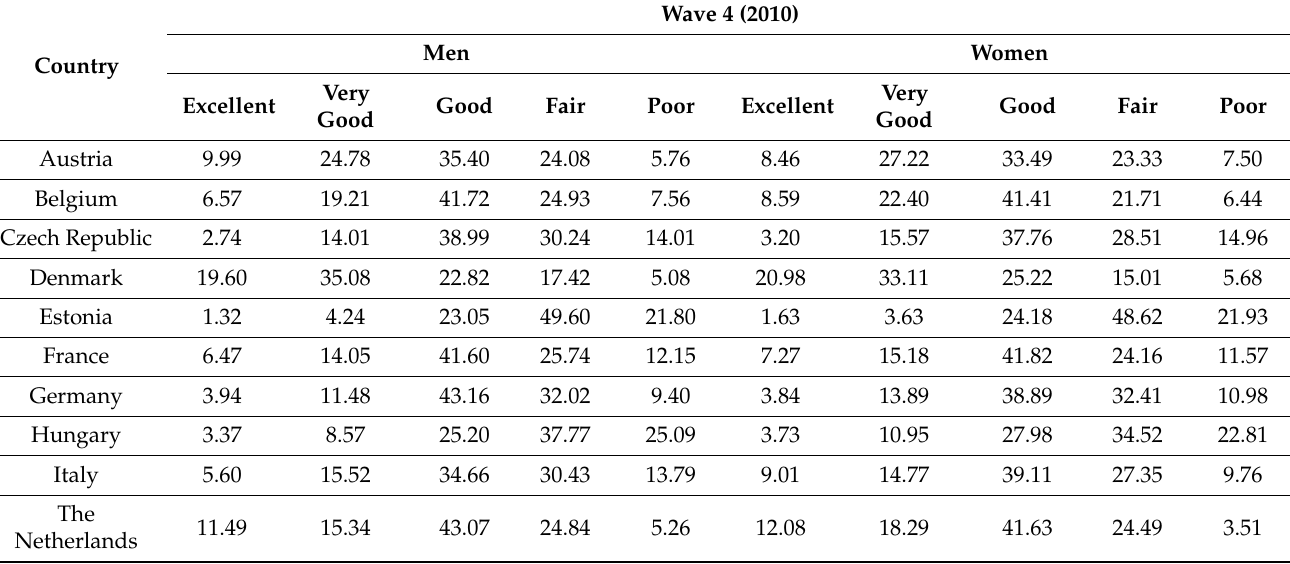
Table 3. Distribution of self-perceived health by gender and country in Wave 4